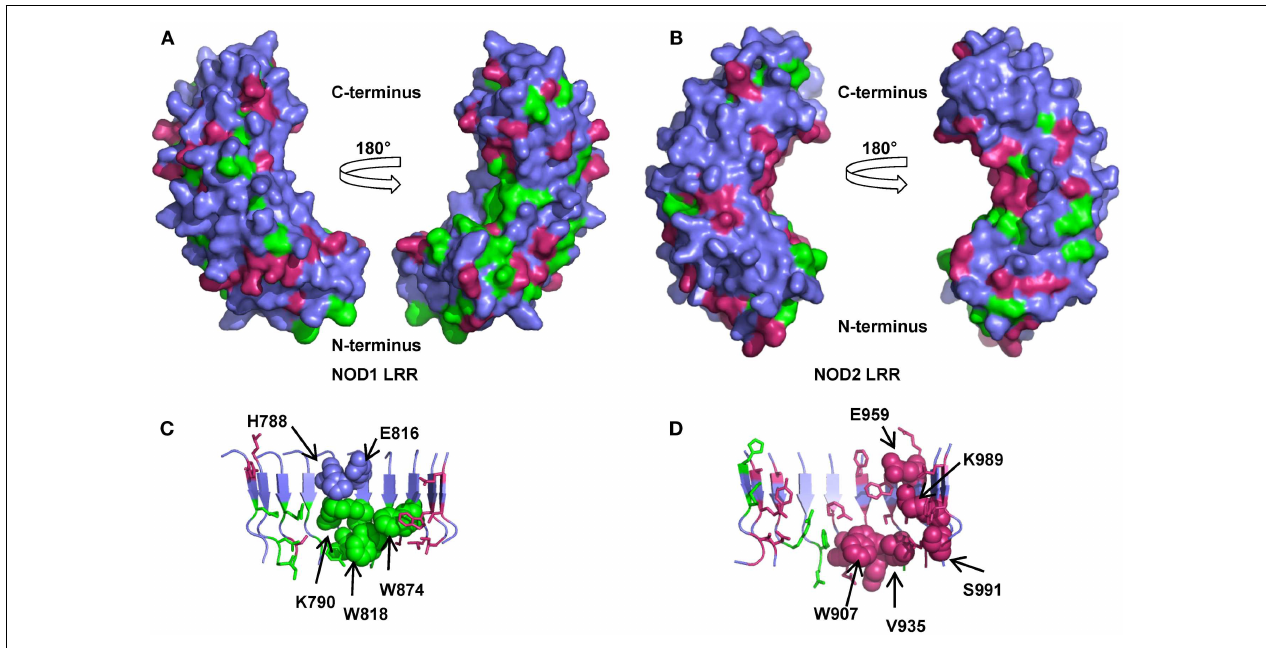
vertical axis. Cartoon representations of the concave surface of the NOD1 (C) and NOD2 (D) LRRs highlight the spatial relationships of residues likely to be involved in ligand detection.The side chains of residues previously implicated in ligand detection and receptor activation are represented as spheres and labeled appropriately except for G792, G818 (NOD1), and G879, G908 (NOD2). Residues are colored as for (A,B) .